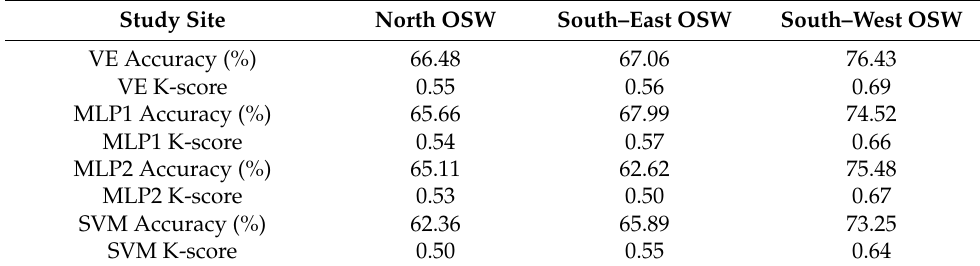
Figure 7. Confusion matrices for the VE, MLP1, SVM, and MLP2 classifiers derived from the HTB SAC study site. Table 4. The accuracy and K-scores for each of the North OSW (N OSW), the South–East OSW (SE OSW), and the South–West OSW (SW OSW) subset